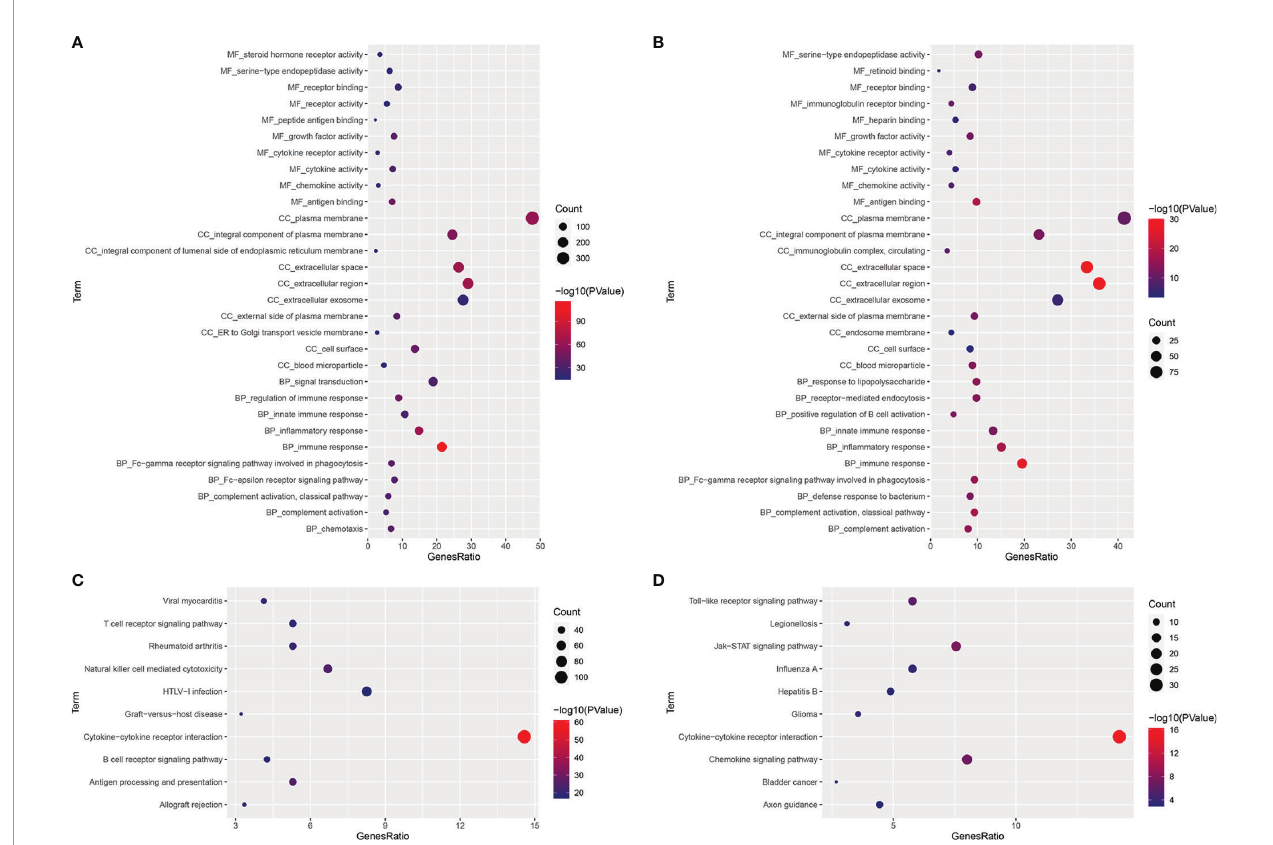
FIGURE 7 | Functional Enrichment Analyses. (A, B) The signi fi cantly enriched GO term (top 10) for those 784 FI-DGEs (A) and those 226 FI-DEGs (B) . (C, D) The signi fi cantly enriched KEGG pathway (top 10) for those 784 FI-DGEs (C) and those 226 FI-DEGs (D) .